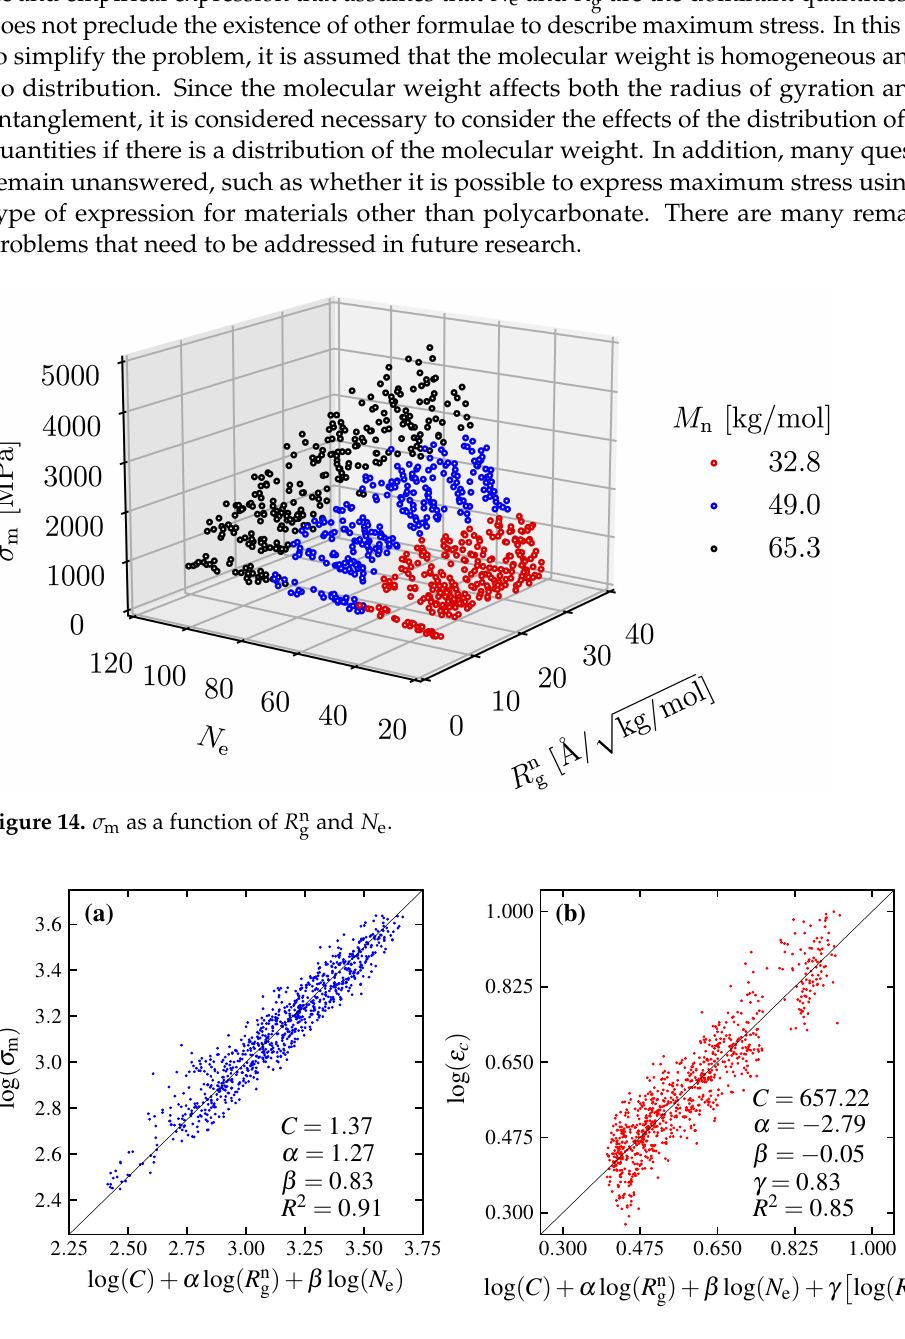
Figure 15. The functions of maximum stress ( σ m ) and critical strain ( ε c ) represented as ( a ) log ( σ m ) and log ( C ) + α log ( R n g ) + β log ( N e ) ; ( b ) log ( ε c ) and log ( C ) + α log ( R n g ) + β log ( N e ) + γ [ log ( R n g )] 2 , respectively. Noting that C , α , β and γ are parameter coefficients from the